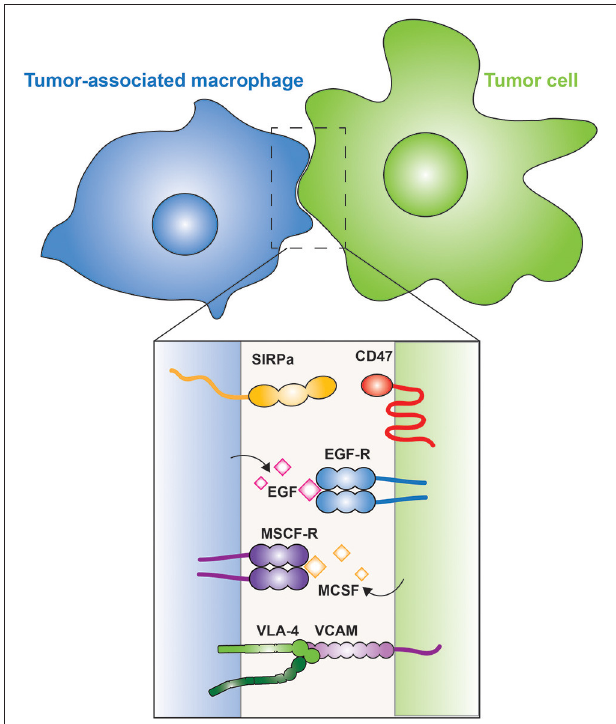
FIGURE 4 | Tumor-associated macrophages. The interaction between a macrophage (blue) and a tumor cell (green) is illustrated. The inset shows the membrane proteins involved in tumor cell evasion and promotion. CD47 is a “don’t eat me” signal expressed on the tumor cell, which is recognized by SIRP α on the macrophage. Tumor cells secrete M-CSF, which is recognized by the M-CSF receptor on the surface of macrophages, leading to the secretion of EGF by the latter; a positive feedback loop between the two cells is thus generated. Metastatic cells express VCAM that interacts with the integrin VLA-4, which activates cell survival pathways in the metastatic